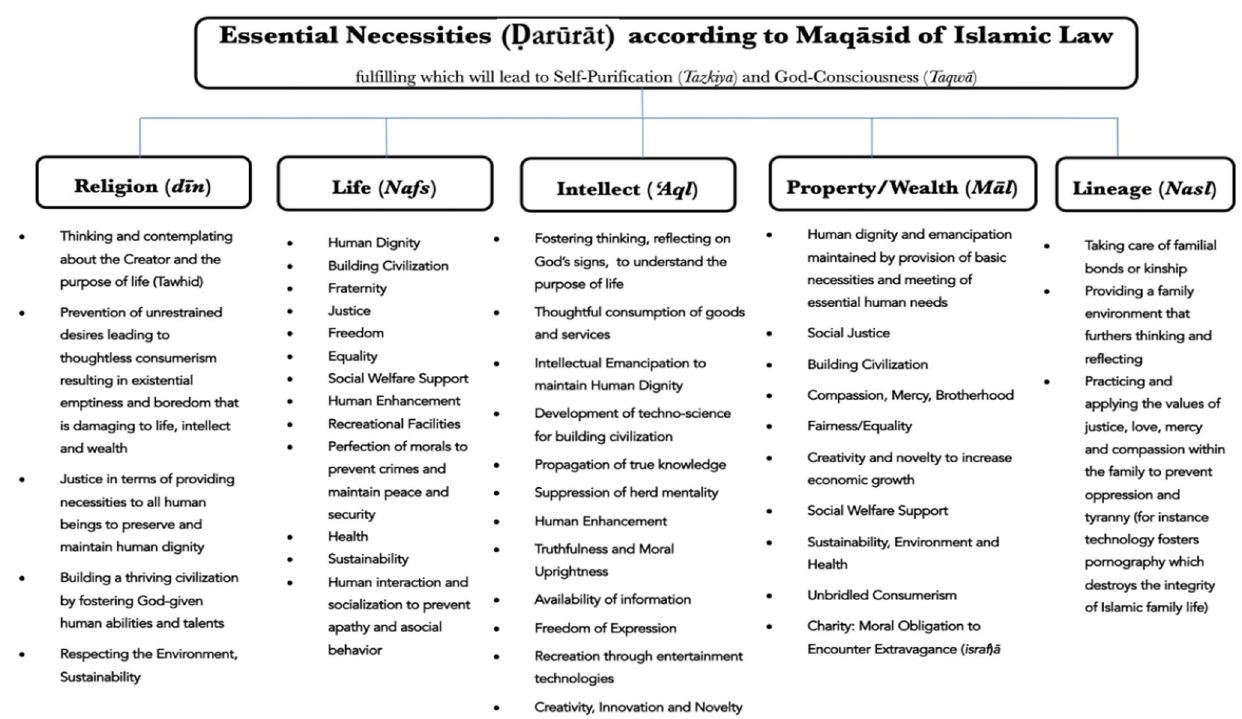
Fig. 2 Essential Necessities according to Maqā ṣ id of Islamic